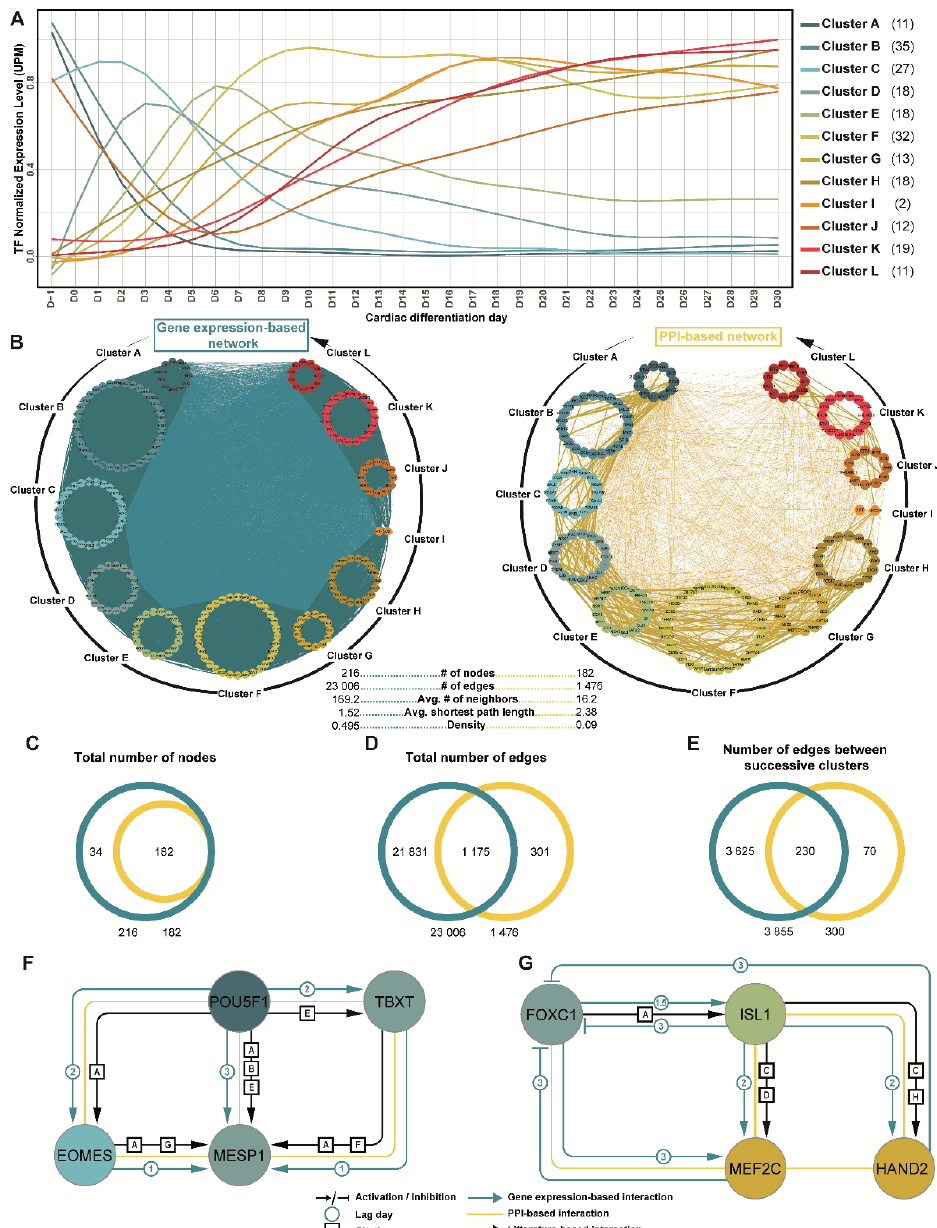
Figure 4. Inferred TF regulatory network governing hiPSC cardiac differentiation. ( A ) Normalized gene expression of the 216 TFs (identified within the top 3000 differentially expressed genes during hiPSC cardiac differentiation) were quantified and averaged in each gene cluster. UPM: UMI per million. Numbers in brackets indicates the TF number per cluster. ( B ) Graphical representation of gene expression ‐ based network and protein ‐ protein interaction ‐ based network (LEAP ‐ and STRING ‐ based method, respectively) of the same TFs as in ( A). Interactions between TFs of suc ‐ cessive clusters are shown using bold lines. #: quantity of each analyzed parameter. ( C – E ) Com ‐ parative quantitative analysis between both networks. ( F , G ) Examples of two literature ‐ based sub ‐ networks. Interactions uncovered in gene expression ‐ based network are shown in blue, in PPI ‐ based network, in yellow, and by literature curation, in black. Node colors correspond to the one of their corresponding gene cluster (as in ( A )). Paper PMID associated with literature ‐ based links: [A] 33803261; [B] 23417899; [C] 34901033; [D] 15253934; [E] 17011492; [F] 21632880; [G] 22402664; [H] 22438573.